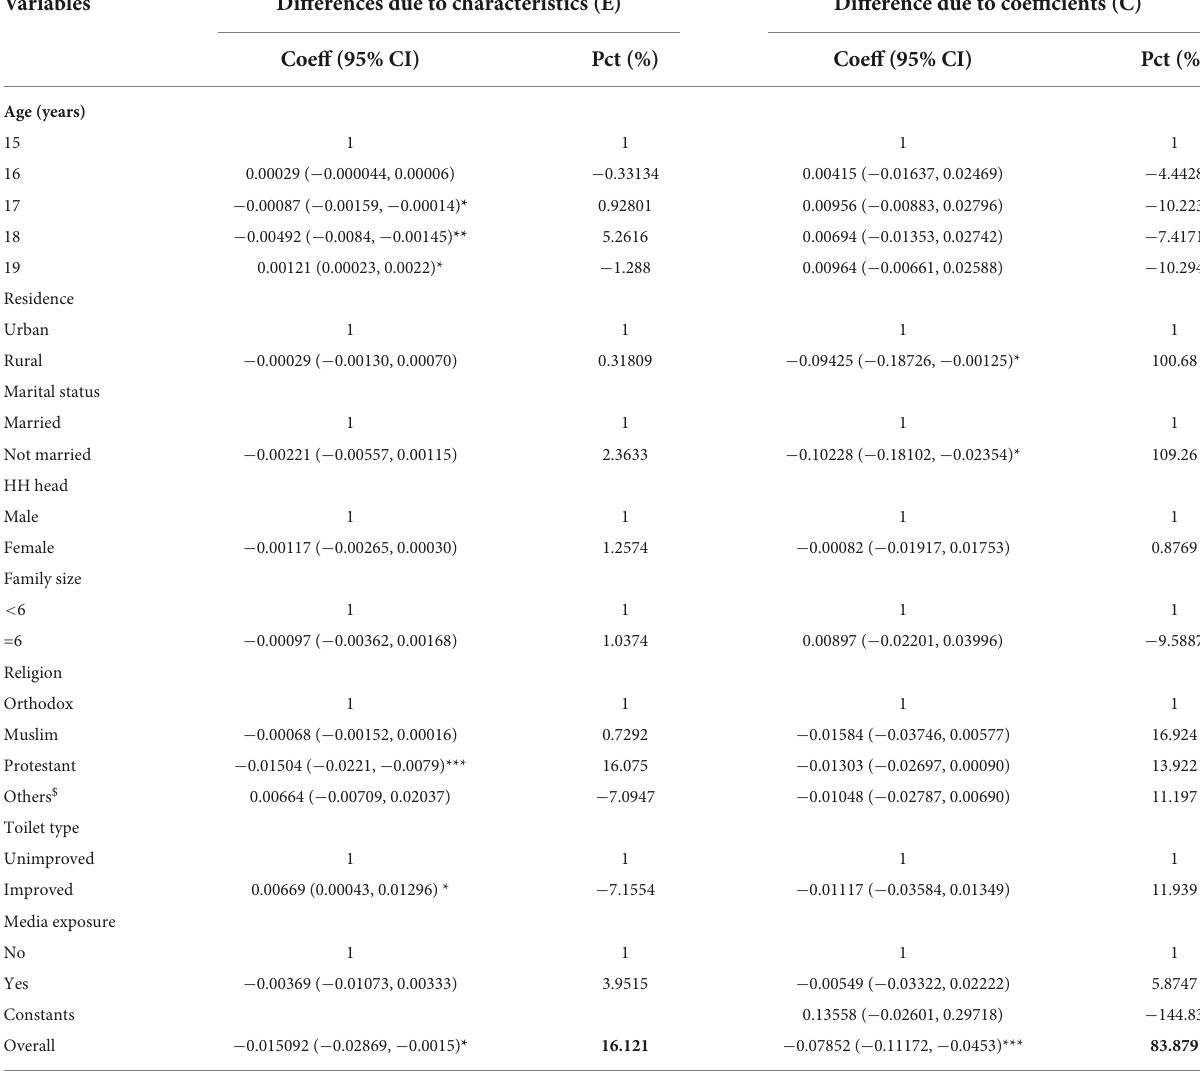
TABLE 3 Detail decomposition of the change in thinness among late adolescent girls in Ethiopia, 2000–2016.